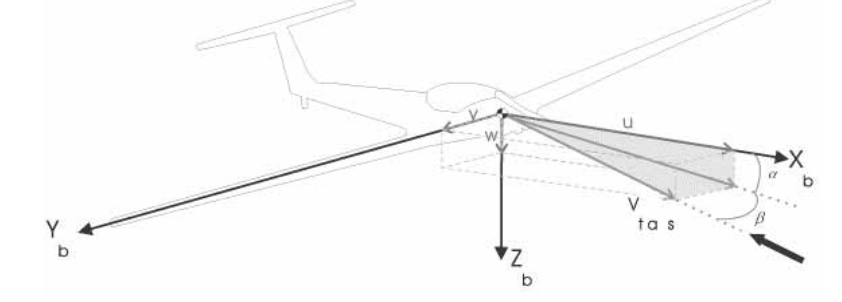
Fig. 2. The wind and body-fixed axes